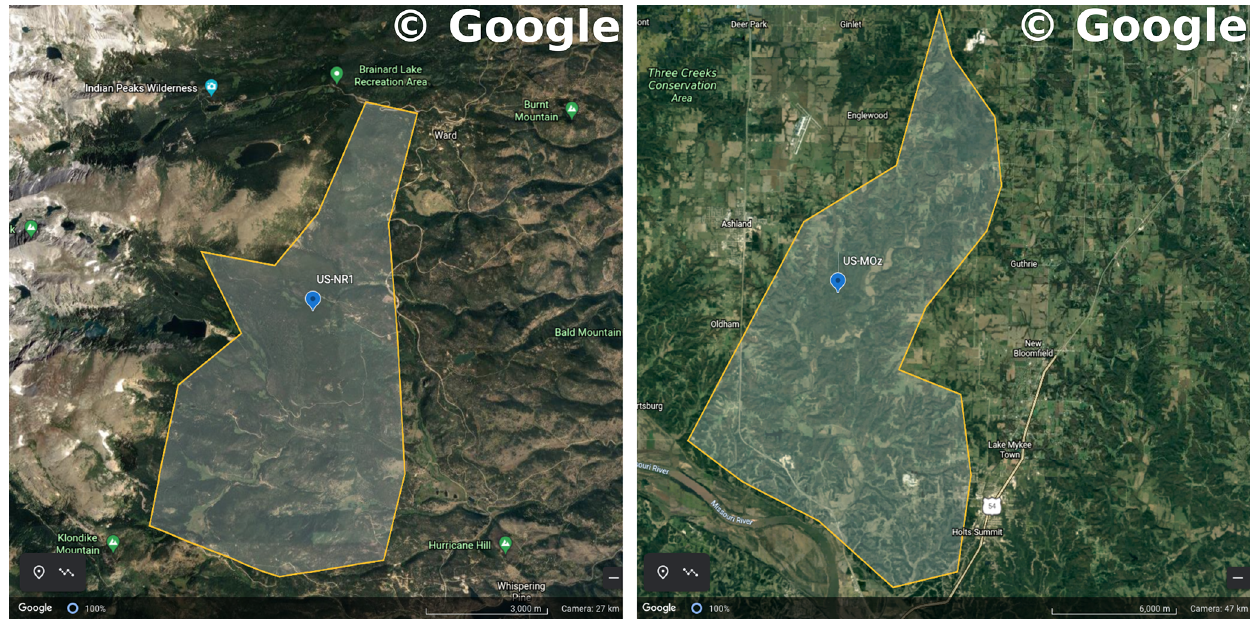
Figure 7. Regions chosen to filter TROPOMI SIF observations. The left panel shows a Google Earth map for the US-NR1 flux tower site (Niwot Ridge, Colorado, USA). The right panel shows a Google Earth map for the US-MOz flux tower site (Ozark, Missouri, USA). The blue symbols show the flux tower locations, and the shaded regions are representative of area around the flux tower site. Map data were sourced from ©Google Earth